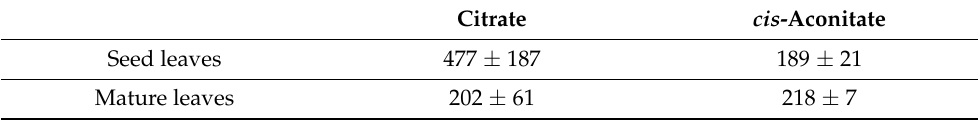
Table 2. Estimated daily intake of itaconate isomers in bread. Table 3. Citrate and cis -aconitate concentrations in wheat seedlings (pmol/mg wet weight) a . Citrate Seed leaves Mature leaves 202 ± 61 218 ± 7 a n = 3 samples of each leaf type. Mean ±